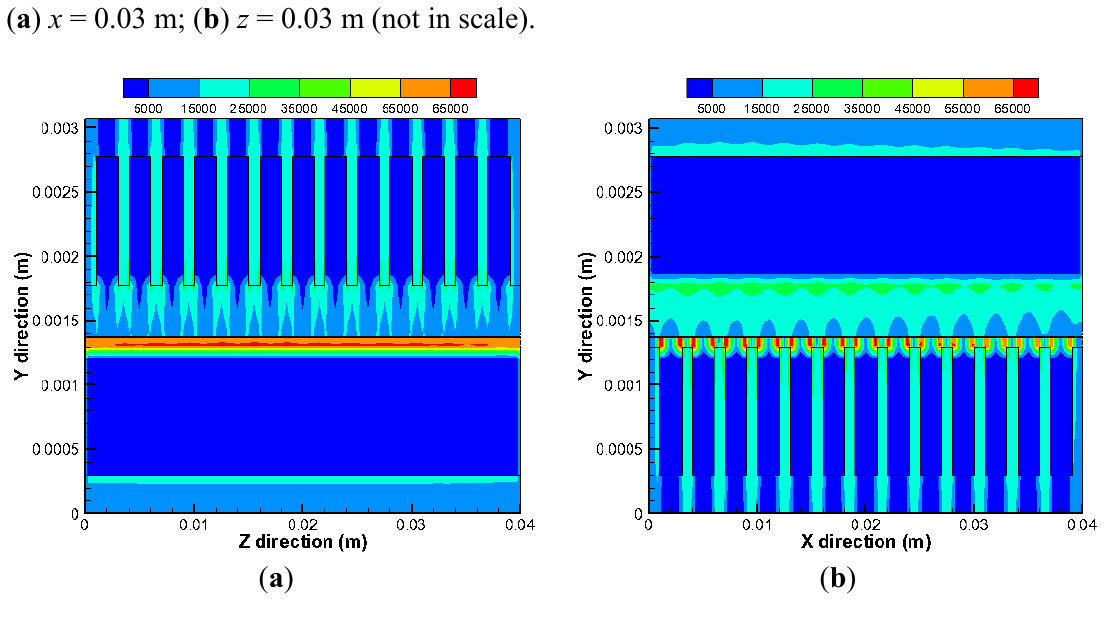
Figure 10. Mole fraction of O